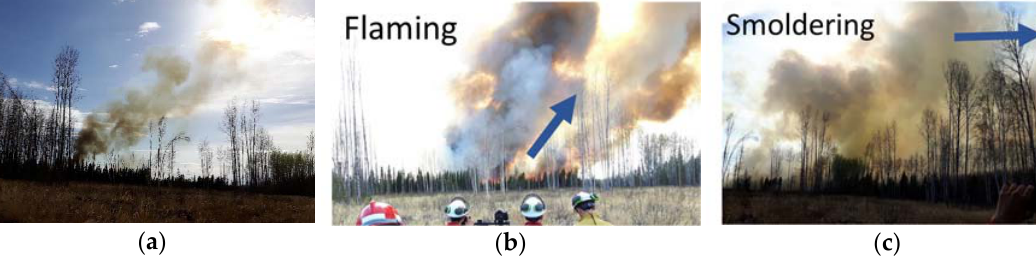
Figure 8. ( a ) Smoke from ignition line of fire (17:50); ( b ) spread of fire towards north (17:52); flaming smoke, and vertical lofting direction is shown by arrow; ( c ) horizontal propagation of smoldering smoke (17:57).